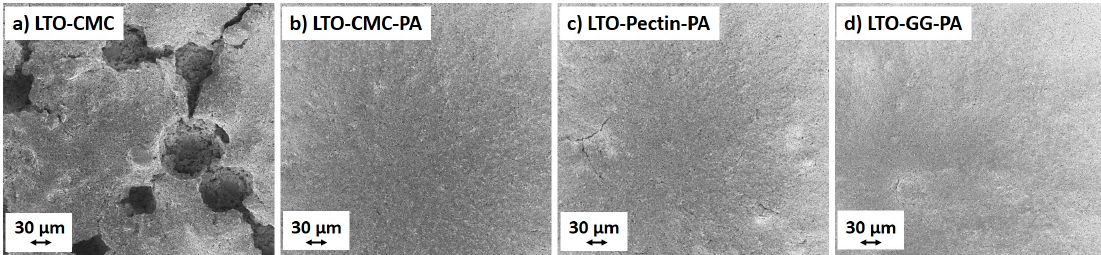
Figure 3. SEM images of unpressed LTO electrodes using: ( a ) CMC as the binder (LTO-CMC); ( b ) CMC as the binder and phosphoric acid (PA) (LTO-CMC-PA); ( c ) pectin as the binder and PA (LTO-pectin-PA); ( d ) and guar gum as the binder and PA (LTO-GG-PA).